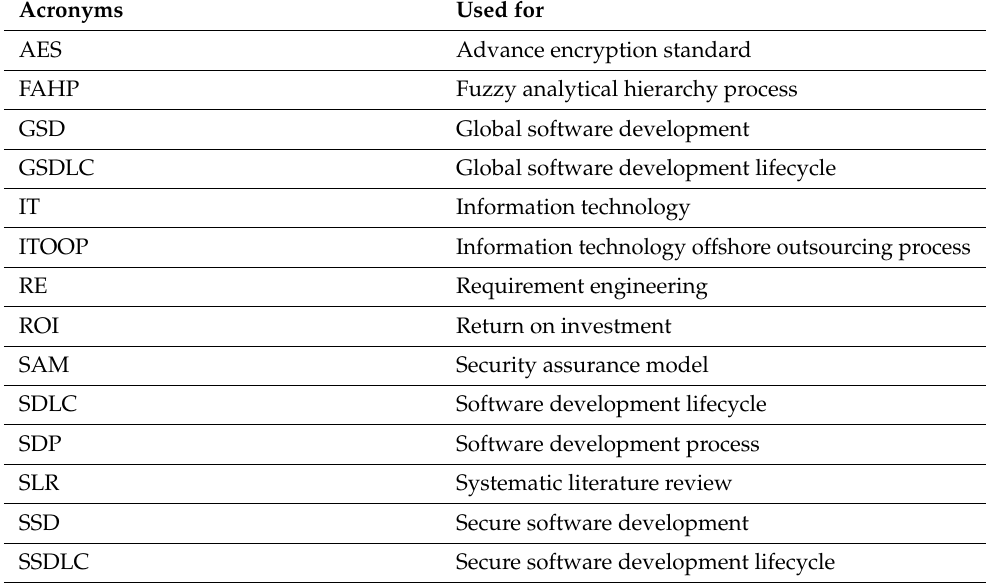
Table 1. List of